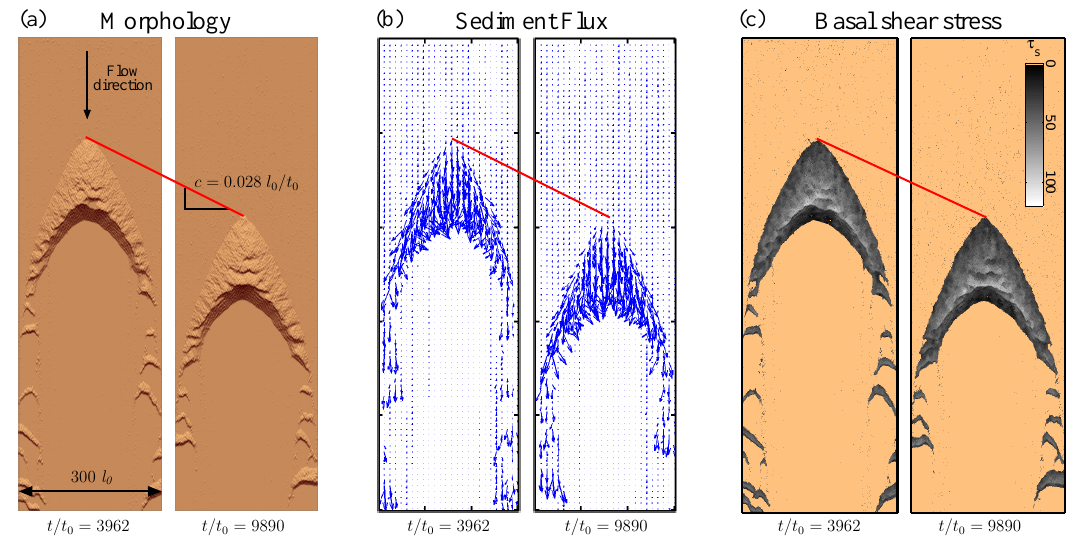
Fig. 1. Morphodynamics of barchan dunes in a wind tunnel using the real-space cellular automaton dune model. (a) Morphology of a barchan dune in a quasi-stationary equilibrium state at t/t 0 = 3962 and t/t 0 = 9890. The flow is from the bottom to the top (black arrow) and the initial condition at t = 0 is a conical sand pile upstream. An equilibrium state can be reached because all the sediment ejected downstream is randomly reinjected upstream. Note the presence of superimposed bed forms. (b–c) Sedimentary fluxes and basal shear stress on the barchan dune (see Narteau et al., 2009, for details about the